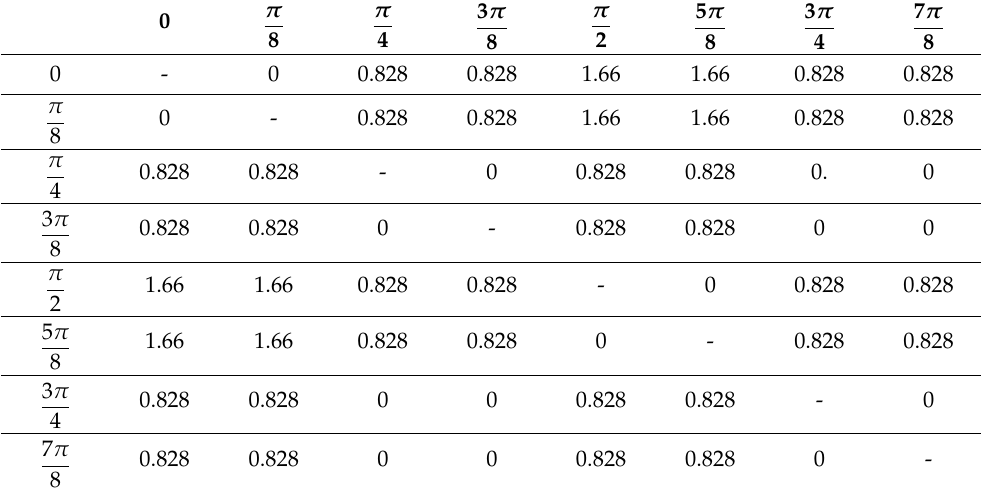
Table 6. Time difference in Hours at peak magnification between a microlensing photometric curve with Φ shown in the first row, compared to the photometric curve with Φ in the first column. R = 7000